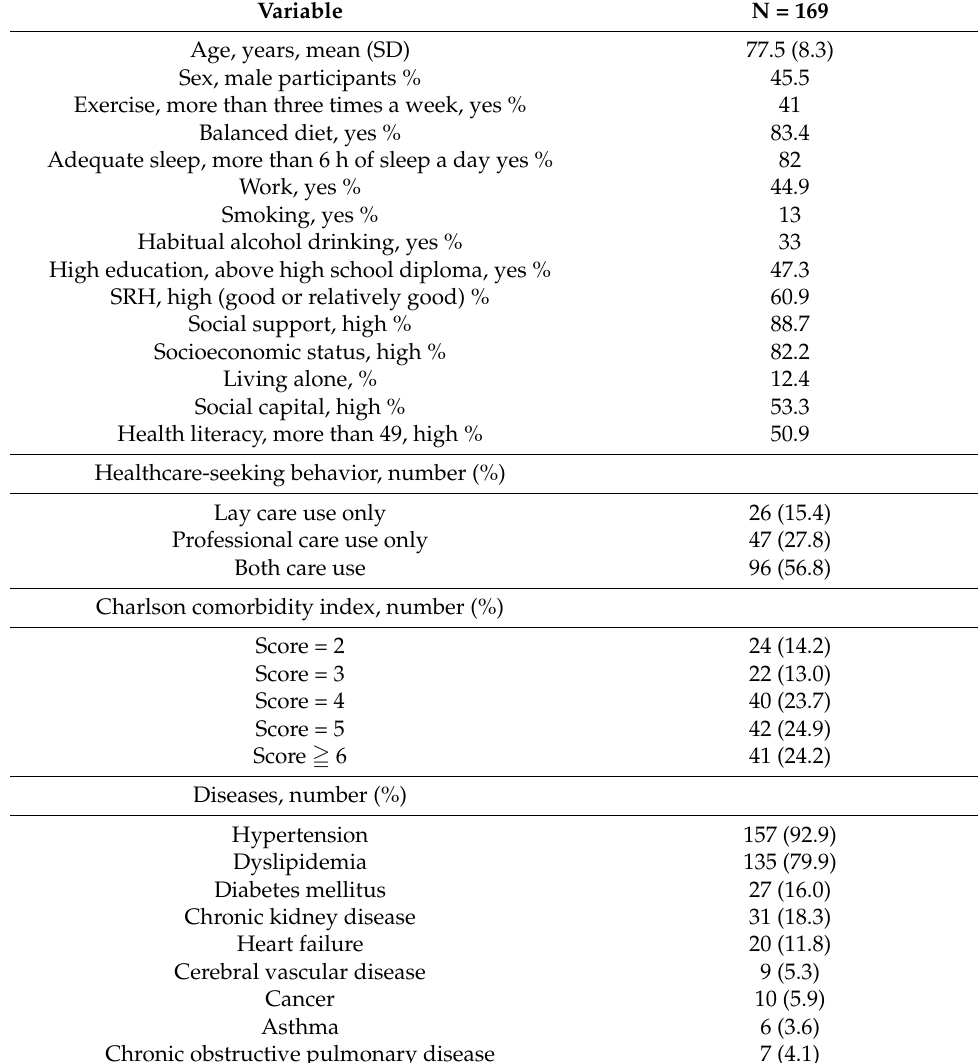
Table 1. Participants’ demographic